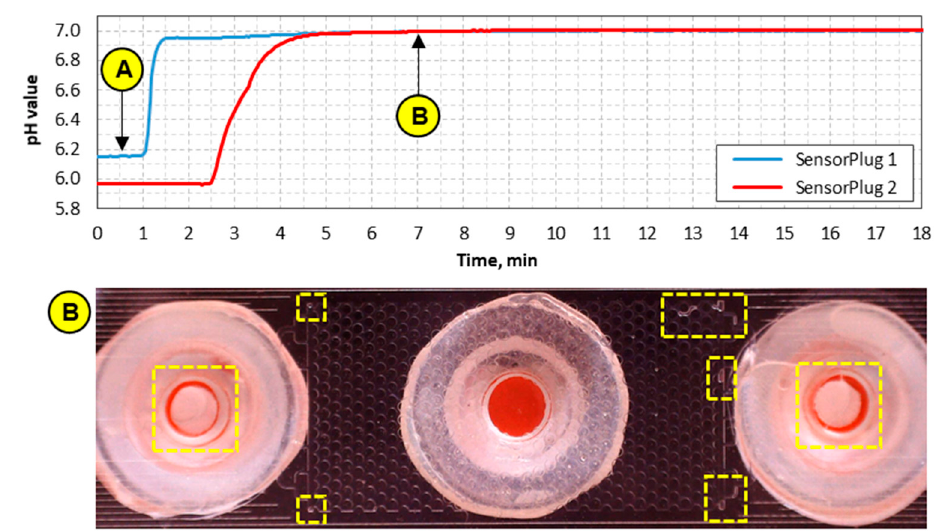
Figure 6. pH values recorded by the SensorPlugs during the injection and flow of pH 7.03 buffer with a rate of 2 µm/min. Images ( A ) and ( B ) were taken before and during the injection of the buffer, respectively. The boxes in Image ( B ) indicate the areas with trapped air.